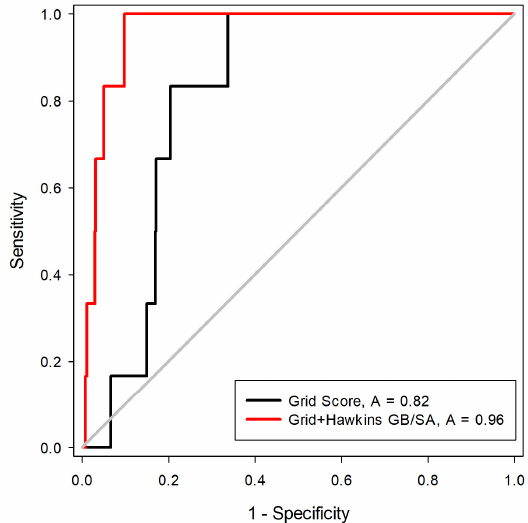
Figure 4. ROC curves for evaluation of Grid-Hawkins GB/SA and Grid Score.